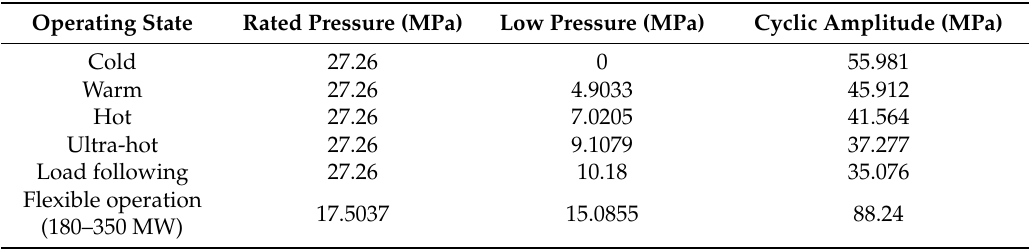
Table 4. Cyclic stress of the vertical water wall during cold, warm, hot, ultra-hot, load following, and flexible